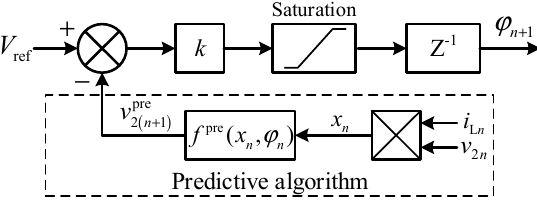
Figure 4. Block diagram of the model predictive control digital controller